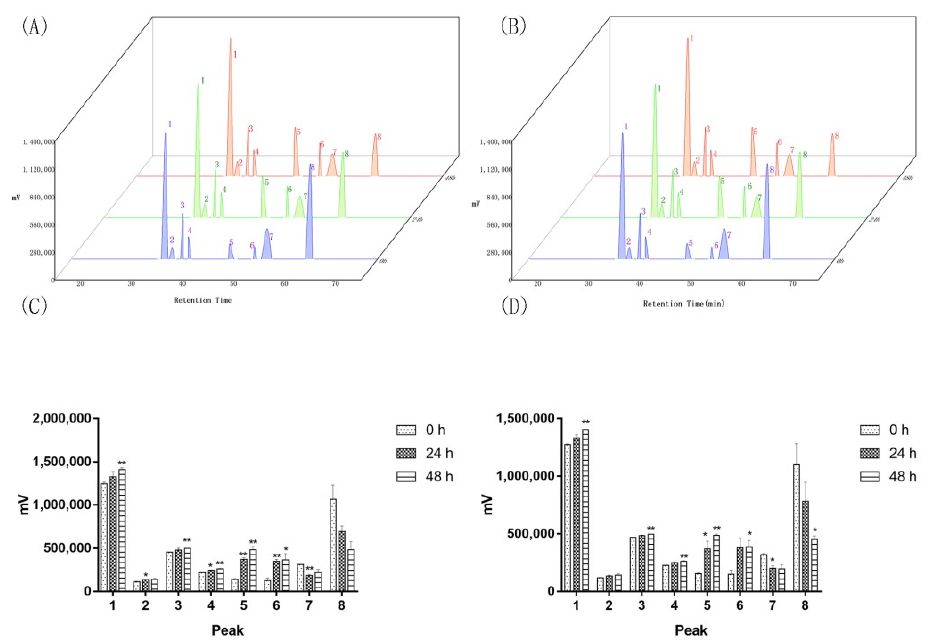
Figure 2. Agarwood powder fermentation ( A ) and ( C ): Bs-2 was added in Agarwood powder and sterilized saline, and then the suspension was thoroughly mixed and incubated. Samples were taken at 0 h, 24 h, and 48 h and filtered for HPLC analysis. ( B ) and ( D ): Bs-4 was added to Agar- wood powder and sterilized saline, and then the suspension was thoroughly mixed and incubated. Samples were taken at 0 h, 24 h, and 48 h and filtered for HPLC analysis. Values are expressed as mean ± SEM, * p < 0.05 and ** p < 0.001 vs. control.